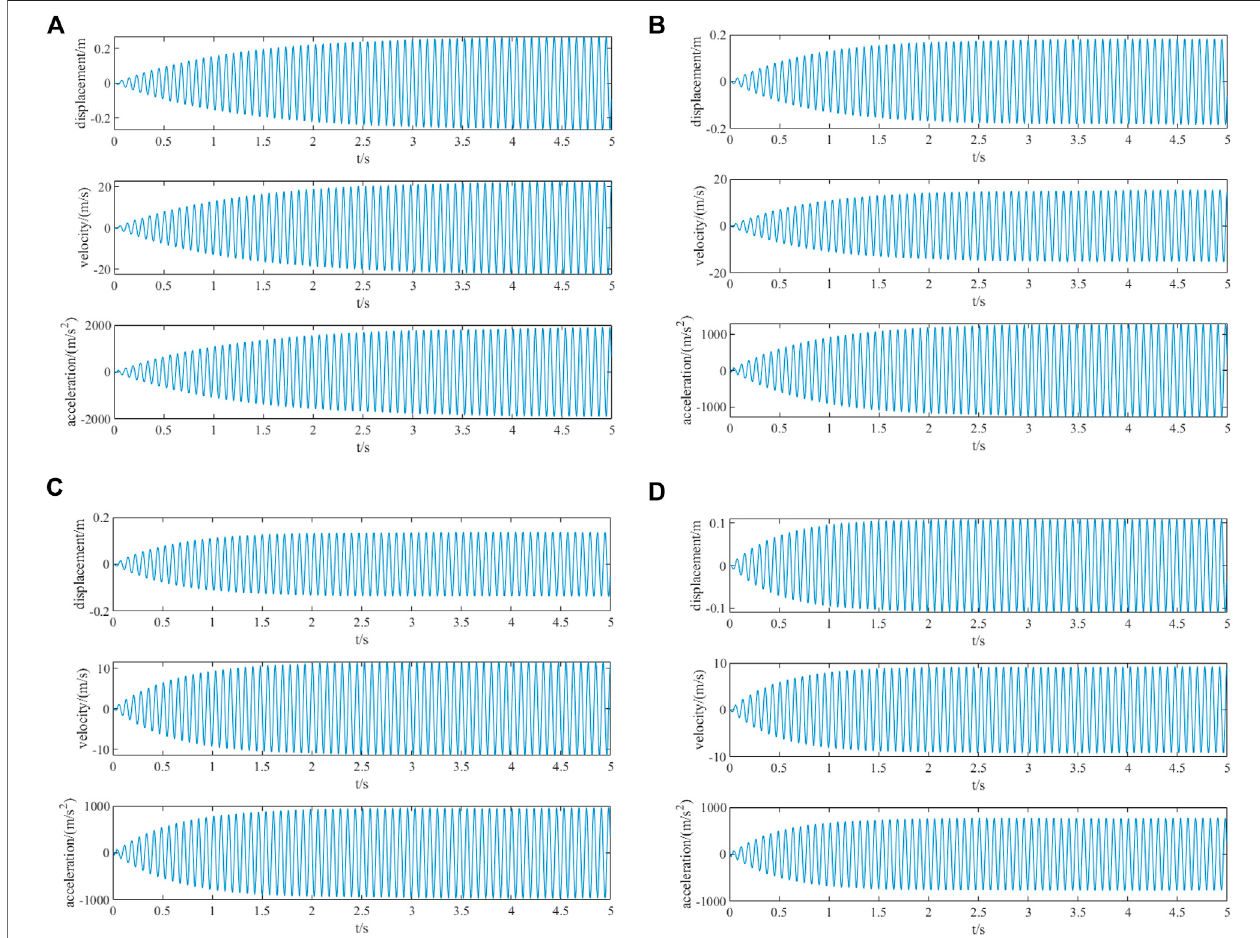
FIGURE 9 | (A) Time history curve of the output response under harmonic excitation (f = 13.3592 Hz and ζ = 0.01). (B) Time history curve of the output response under harmonicexcitation (f = 13.3592 Hz and ζ = 0.015). (C) Timehistory curveofthe outputresponseunder harmonic excitation (f =13.3592 Hz and ζ = 0.02). (D) Time history curve of the output response under harmonic excitation (f = 13.3592 Hz and ζ =